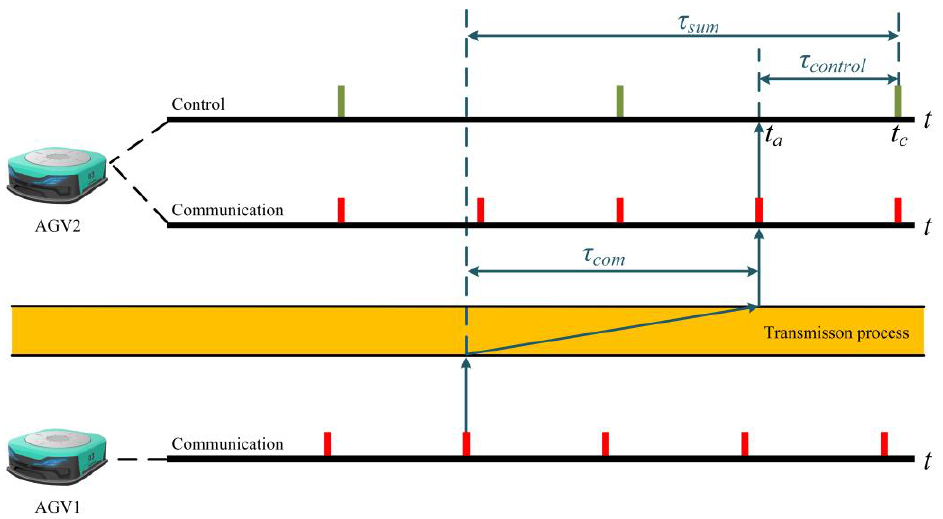
Figure 6. Total delay in multi-cycle system.